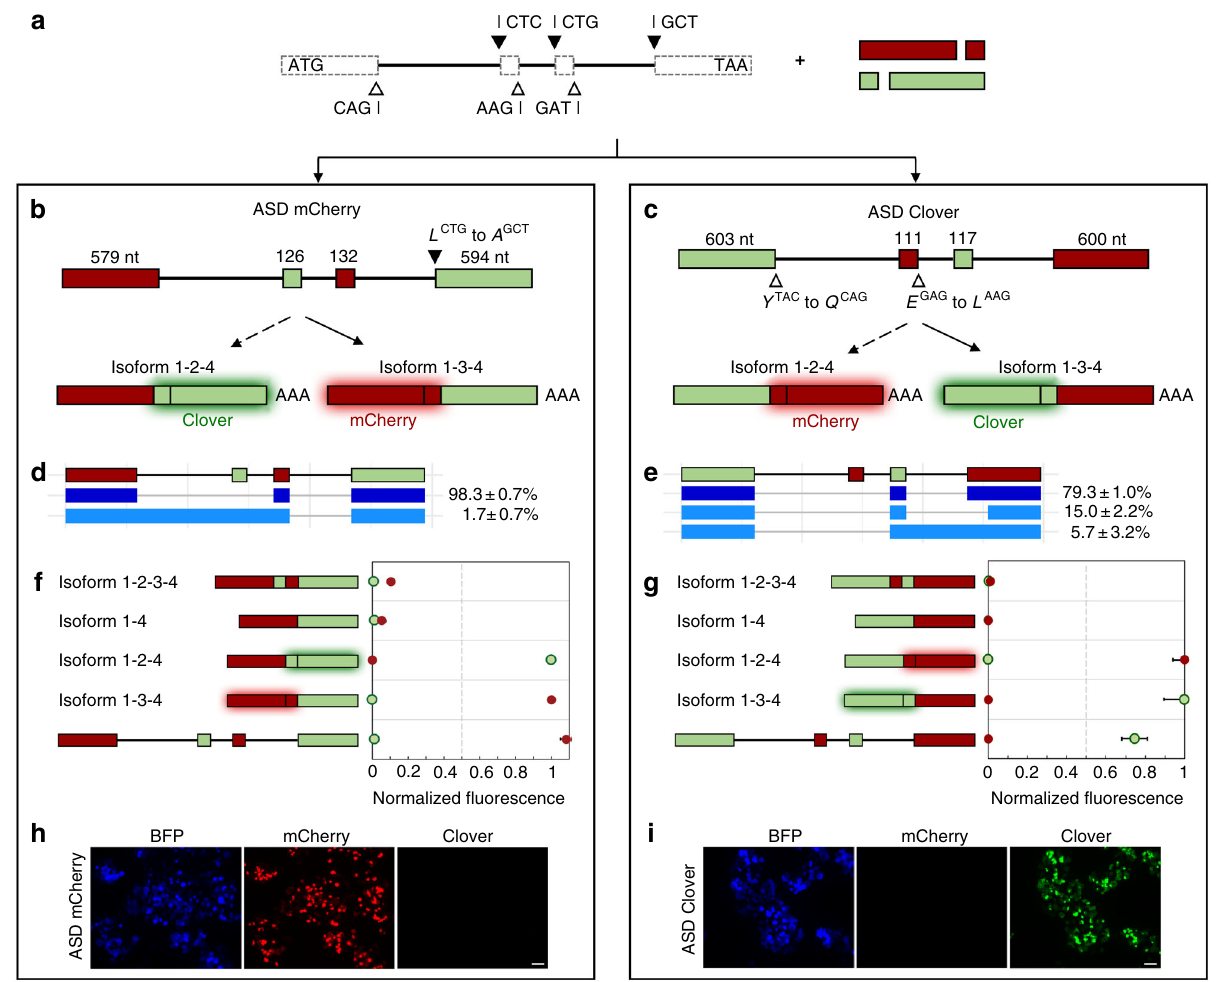
Fig. 2 Design and validation of fl uorescent MEAS devices. a Fluorescent ASDs are constructed using the base intron framework and synthetic fl uorescent protein exons. The de fi ned splice site sequences are incorporated into the programmable exons. The fi rst codon of each exon (noted to the right of the black triangle) and last codon of each exon (noted to the left of the white triangle) is set to assure proper exon de fi nition when possible. b ASD mCherry and c ASD Clover were designed to generate distinct fl uorescent outputs as a result of a single MEAS event. The lengths, in nucleotides, of the exons are noted. Speci fi c codons were set to maintain splice site sequences and their corresponding 1-letter amino acid codes are shown in italicized bold. Plasmids encoding each ASD or spliced isoform control with a BFP transfection marker were transfected into HEK-293T cells. RNA was extracted for characterization using long-read sequencing and protein levels were assayed for fl uorescence using fl ow cytometry. RNA isoform pro fi les and relative isoform abundances for d ASD mCherry and e ASD Clover. RNA isoform 1-3-4 and its derivatives are colored blue. The RNA isoform abundance percentages include ±1 standard deviation from biological duplicates. mCherry and Clover fl uorescence levels for f ASD mCherry and g ASD Clover with their corresponding spliced controls 1-2-3-4, 1-4, 1-2-4, and 1-3-4. The median fl uorescence of each population was measured and normalized to the median fl uorescence intensities of the BFP transfection marker and the spliced controls. Median values from biological triplicates were averaged and reported with an error range of ±1 standard deviation. Fluorescence microscopy images of HEK-293T cells transfected with h ASD mCherry and i ASD Clover. Scale bars represent 50 μ m. Source data are provided as a Source Data fi